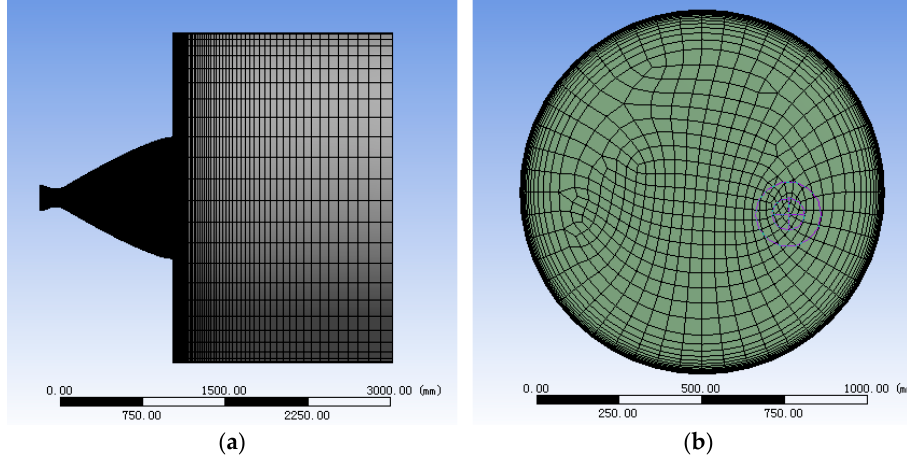
Figure 17. Flow field grid. ( a ) Full field grid. ( b ) Nozzle outlet grid.